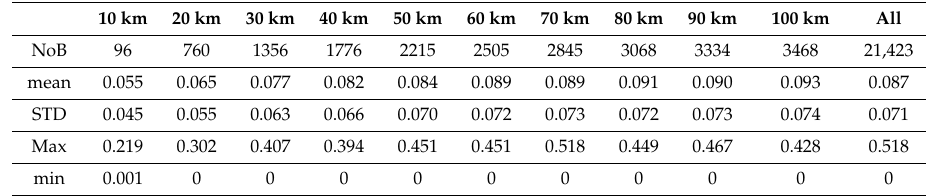
Figure 4. Magnitude of relative differences between GEOID_LSC with 803 GNSS/levelling points over 21,423 baselines (blue), fourth-order tolerance (orange) and third-order tolerance (purple). Table 3. Relative differences between 803 GNSS/levelling points and GEOID_LSC, per baseline length (every 10 km) (NoB: Number of Baselines). Unit: